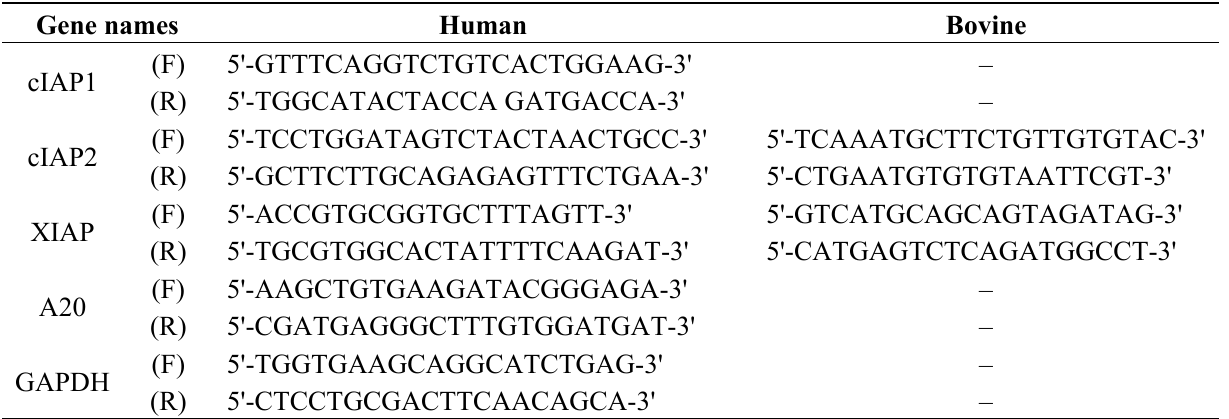
Table 2. The sequences of the qPCR